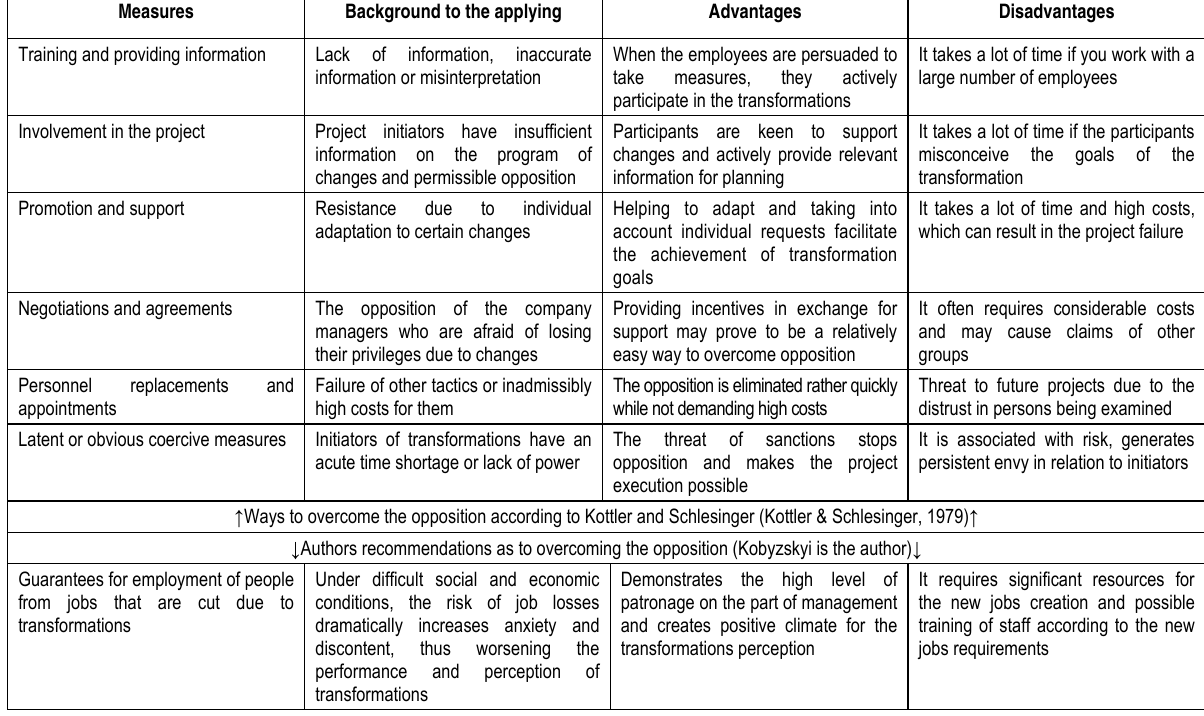
Table 1. The ways to overcome staff opposition to the organizational changes at the industrial